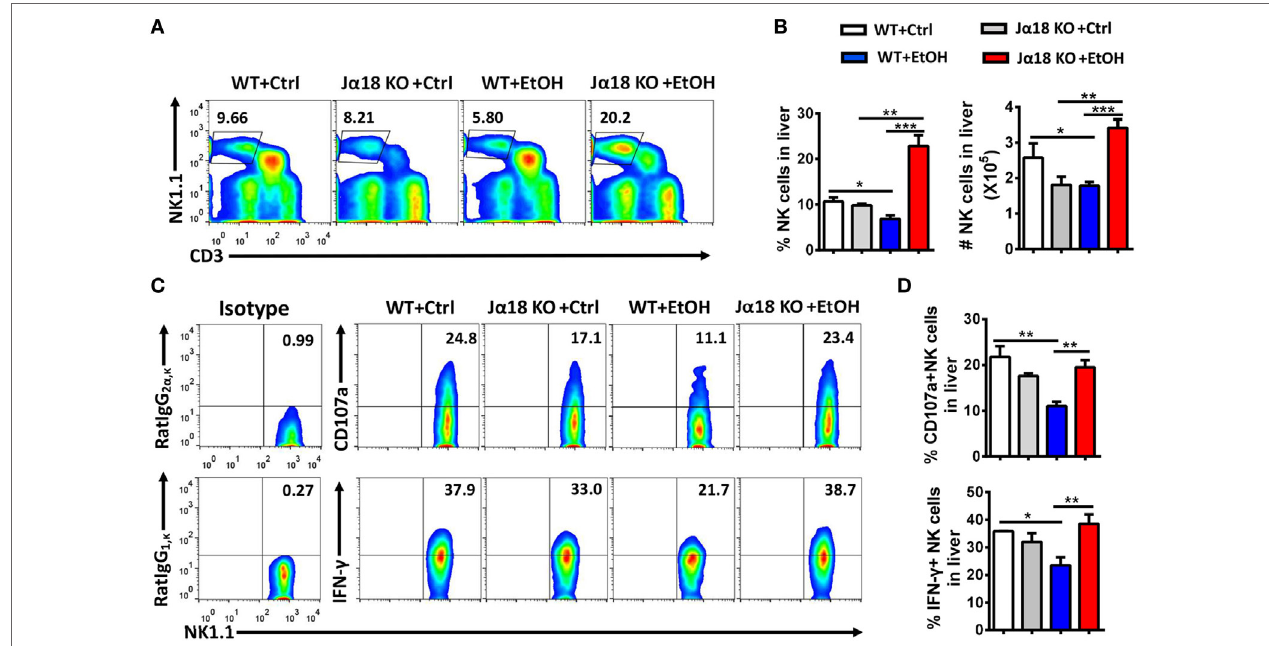
FigUre 6 | The number and function of natural killer (NK) cells were markedly increased in J α 18 − / − mice. (a–D) Wild-type or J α 18 − / − mice were fed control or ethanol diets for 10 days and subsequently received gavage. The mice were sacrificed 9 h after gavage, and the liver mononuclear cells were then isolated. (a) The frequency of CD3 − NK1.1 + NK cells among all leukocytes in the liver was analyzed by flow cytometry. (B) Statistical analysis of the percentage and absolute number of the NK cells shown in (a) . (c) Representative CD107a expression (without PMA stimulation) and interferon- γ (IFN- γ ) release (with PMA stimulation) in hepatic NK cells. (D) Statistical analysis of the percentages of CD107a + and IFN- γ + NK cells shown in (c) . The data are representative of more than three independent experiments and are shown as the mean ± SEM ( n = 3–6). * P < 0.05; ** P < 0.01; *** P <